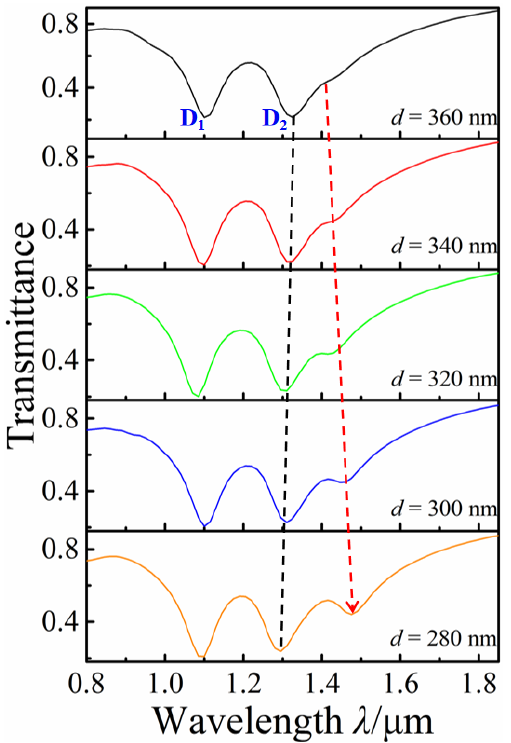
Figure 6. Transmission spectra with the different horizontal double nanorod distance d .